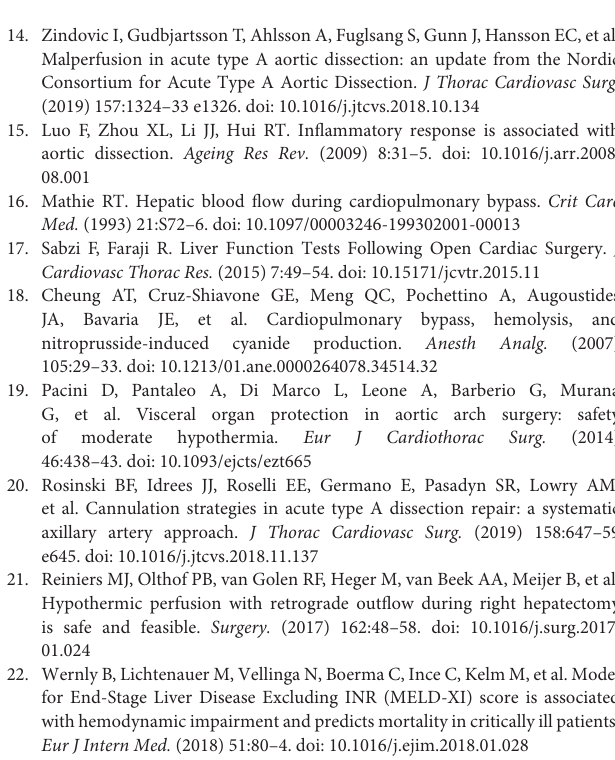
Supplementary Figure 3 | Restricted cubic splines visualizing the relationship between cardiopulmonary bypass duration and PHD on the multivariable logistic model ( P for non-linearity = 0.178). PHD, postoperative hepatic dysfunction.